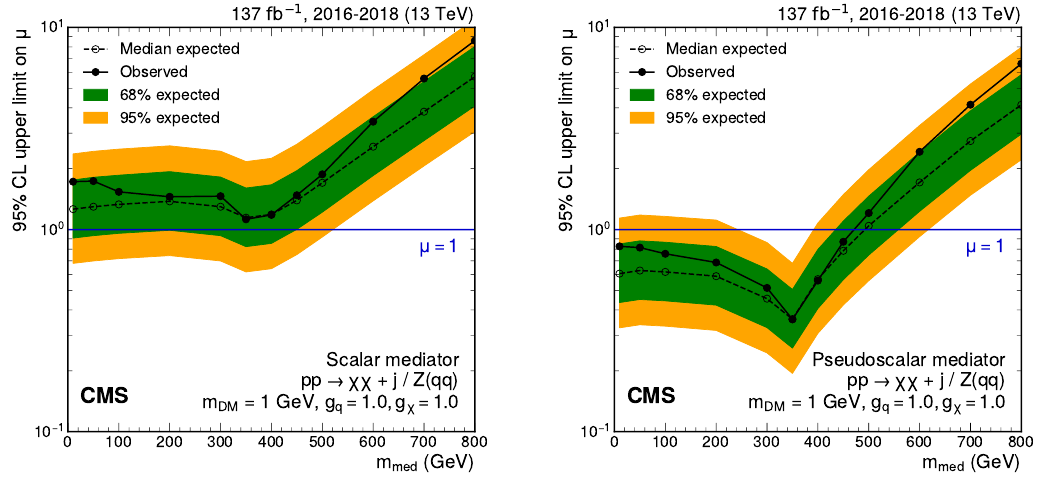
as a function of m for sce- theo med = 1 . 0 , g = 1 . 0 , q χ = 1 GeV. The blue solid line indicates the exclusion boundary µ = 1 . DM values up to 470 GeV are excluded (490 GeV med